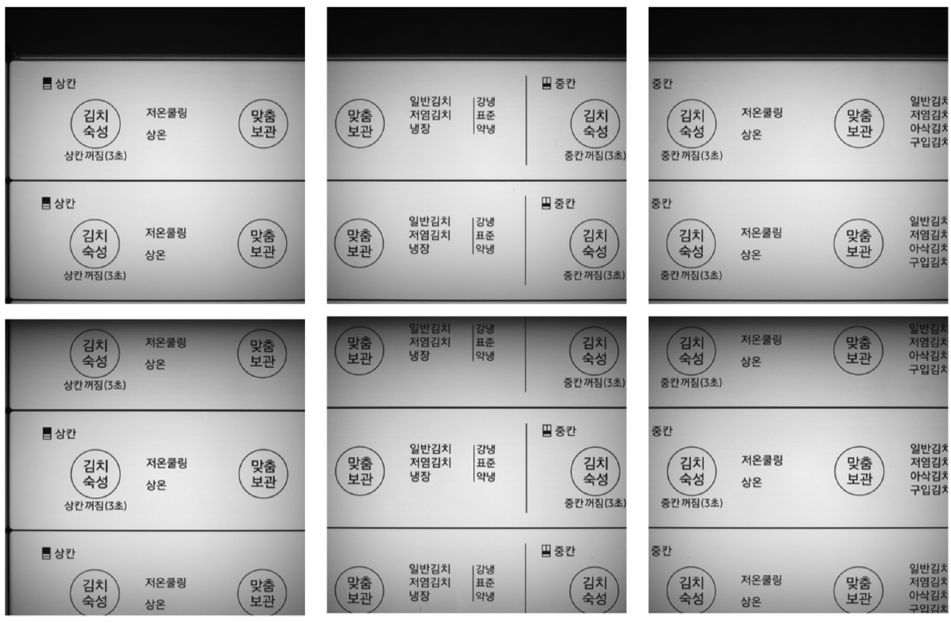
Figure 16. Product images collected using a vision camera.